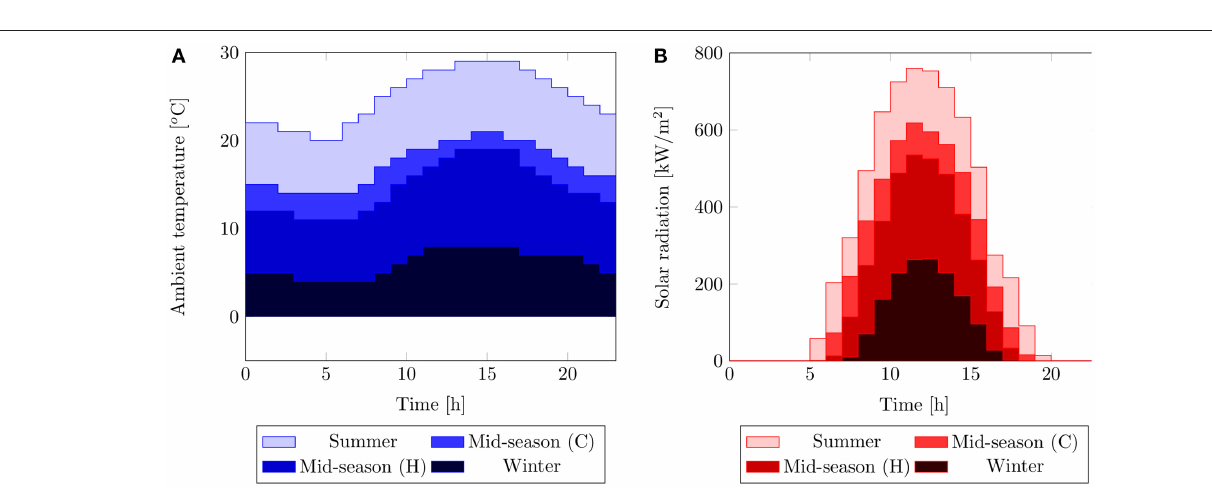
FIGURE 3 | Average ambient conditions for the off-grid dwelling case study. (A) Ambient temperature, (B) Solar radiation (Hence changing “power” to